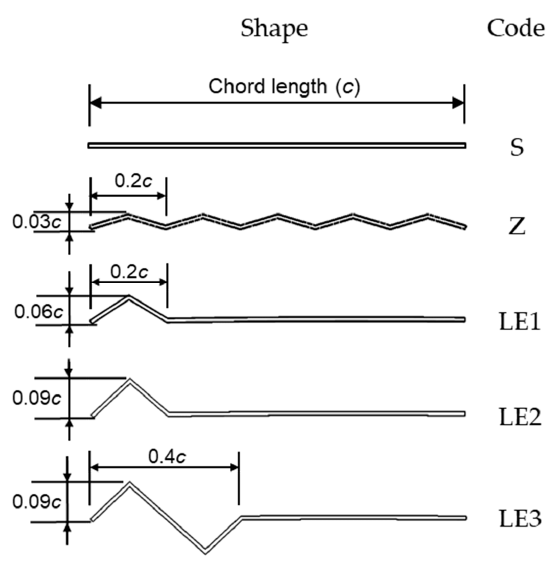
Figure 5. Wing profiles used for the CFD study.